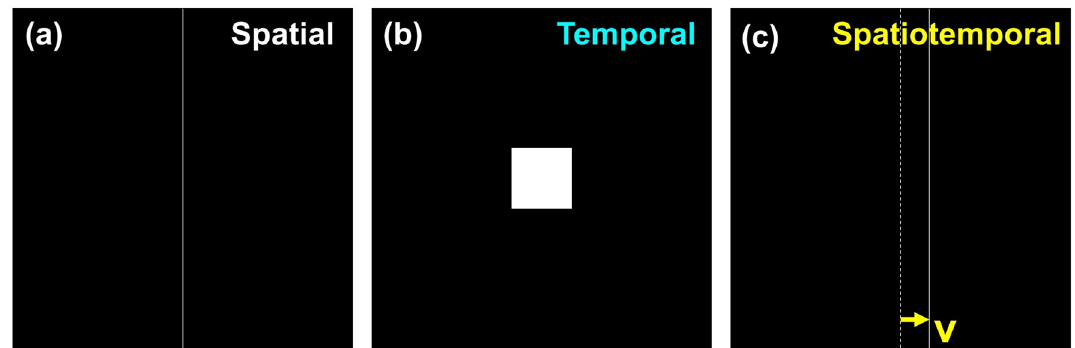
Figure 2. Illustrations of the test patterns used for the spatial ( a )—a static single pixel line, temporal ( b )—a 100 × 100 pixels white box, and spatiotemporal measurements ( c )—a moving line with a velocity v in degree per second.